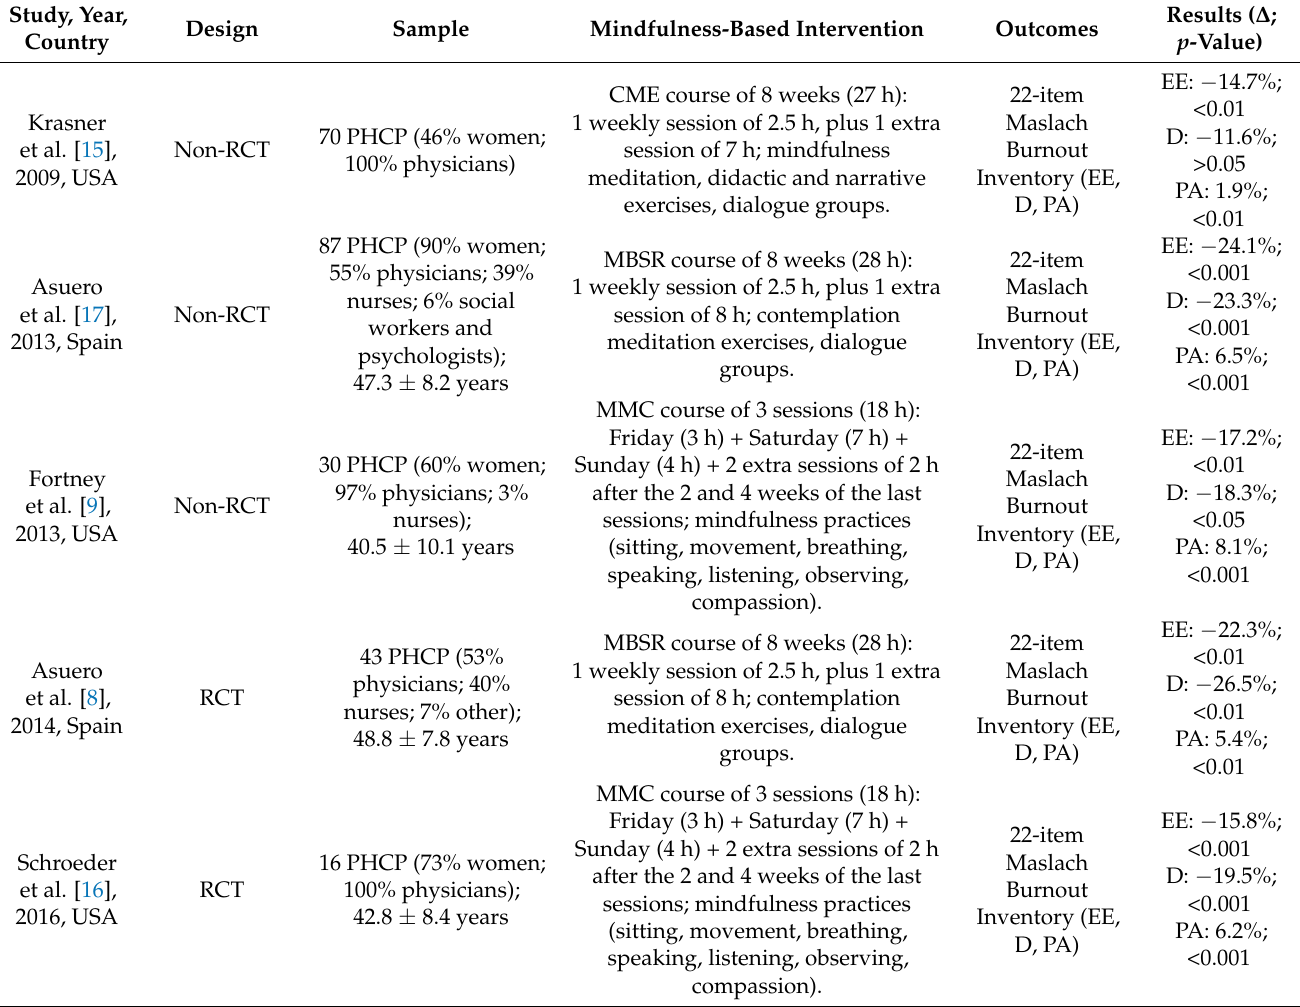
Table 1. Characteristics of the included